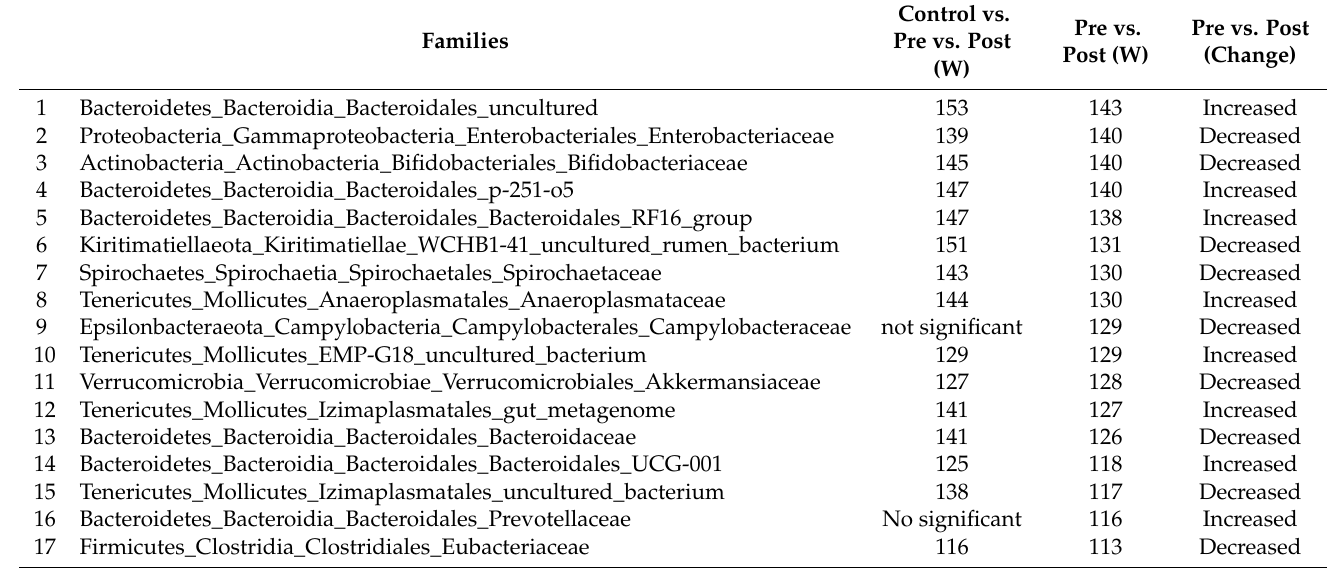
increased post-treatment in the high dose, was a member of the core fecal microbiota. Table 4. Results of ANCOM analysis showing bacterial families significantly different among control, pre-treatment, and post-treatment samples. High W values indicate significant differences in abundance levels between groups.